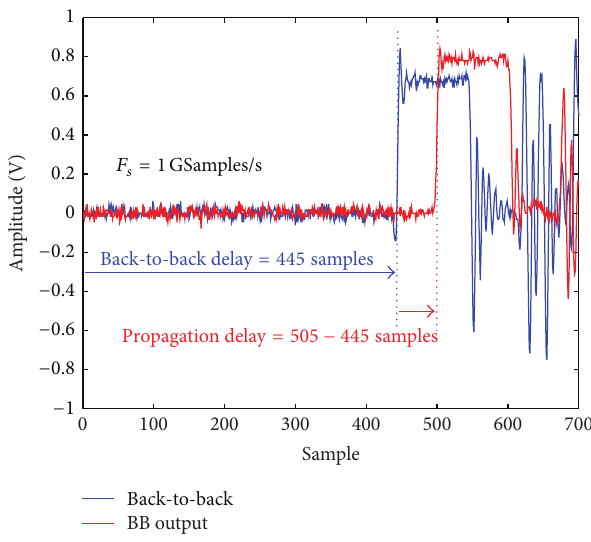
Figure 9: Propagation delay estimation for determining link range in the anechoic